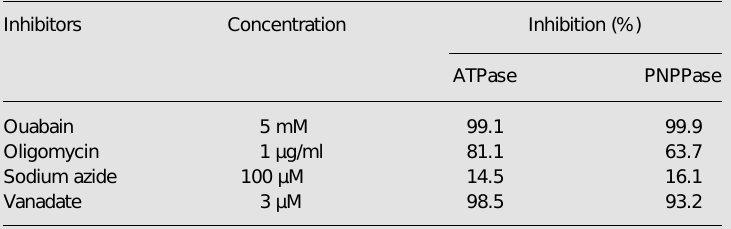
Table 2. Effect of several inhibitors on adenosine 5’-triphosphatase (ATPase) and p-nitrophenyl phosphatase (PNPPase) activities of purified Na,K-ATPase from rabbit kidney outer medulla.